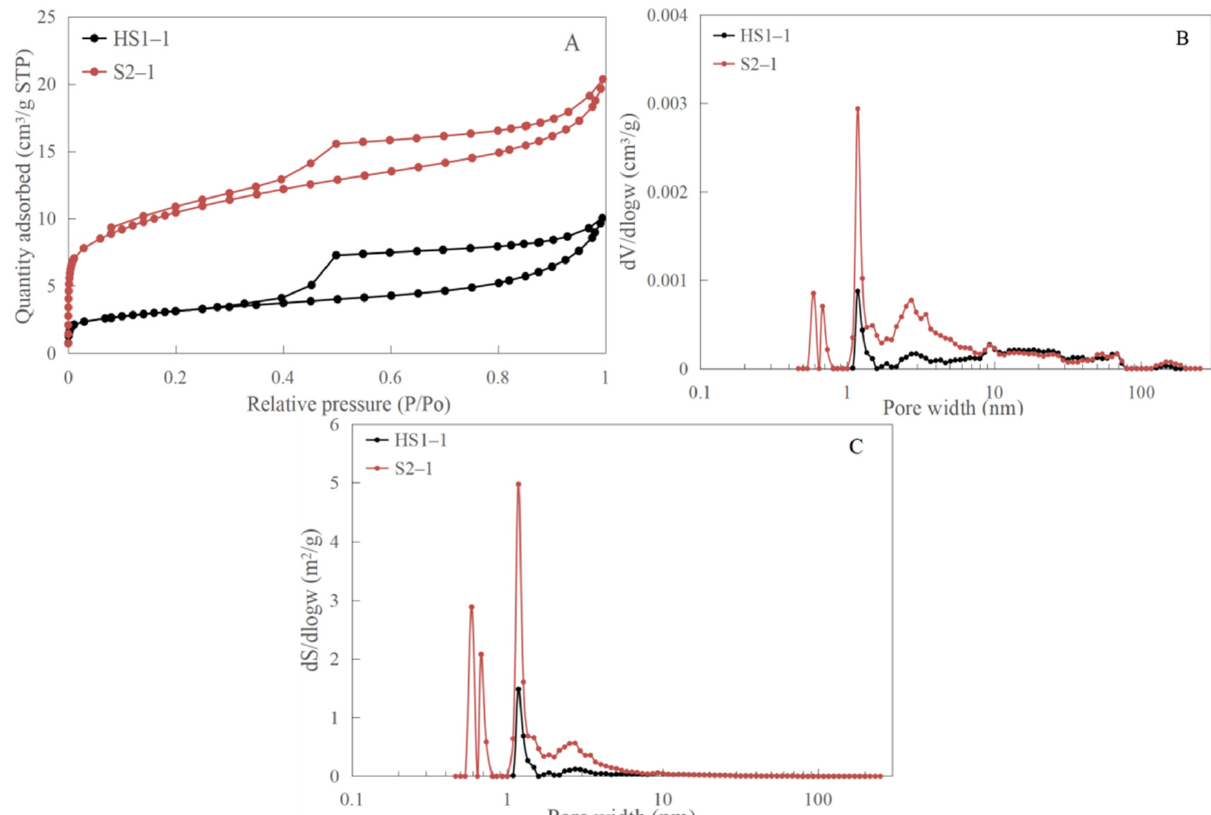
Figure 4. Low-pressure N 2 adsorption isotherms ( A ) and pore width distribution ( B , C ). The plot of dV/dlogw versus pore width (w) was frequently used to investigate the pore width distribution of nanopores and to assess the partial porosity of pores at any width (Figure 4B), which was preferable calculated by the DFT model [40,46]. The pore